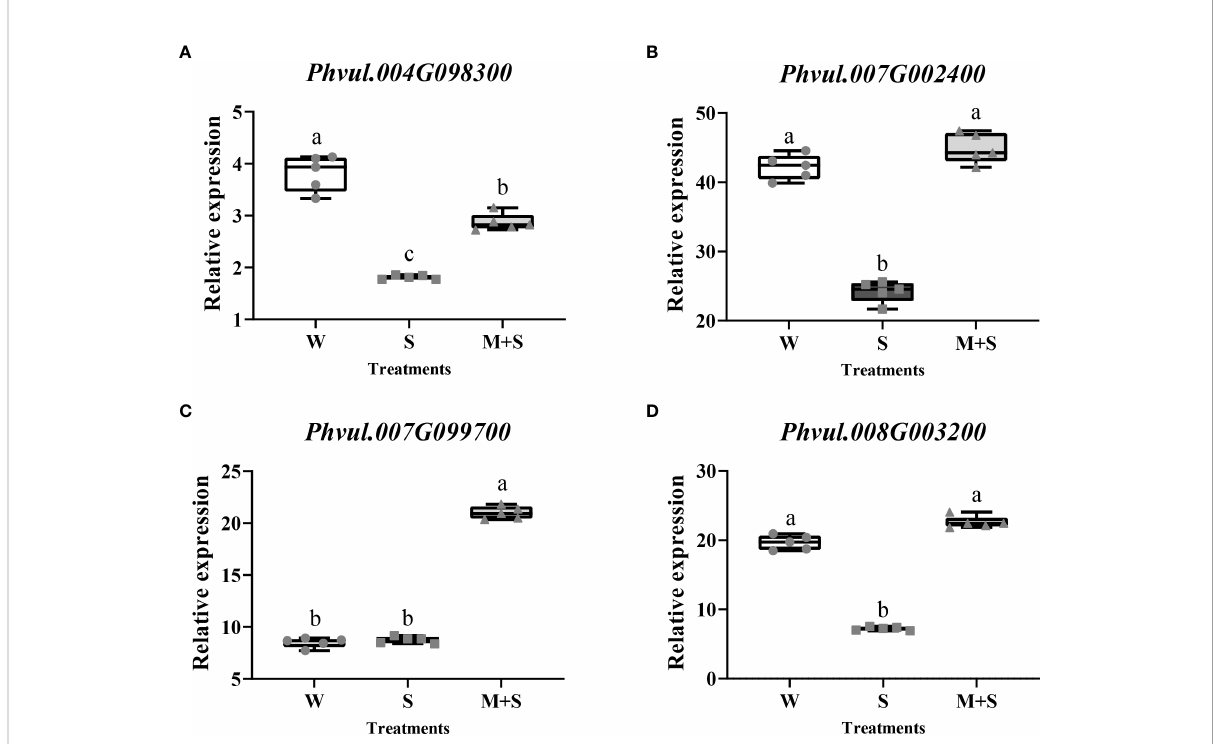
FIGURE 2 Gene expression analysis of the cell wall-related GO terms enriched in the common bean under W (water: CK), S (salt), and M+S (melatonin with salt) treatments at sprouting stage. Different lowercase letters in the same column indicate signi fi cant differences between the treatments (P<0.05). (A) Expression analysis of the Phvul.004G098300 . (B) Expression analysis of the Phvul.007G002400 . (C) Expression analysis of the Phvul.007G099700 . (D) Expression analysis of the Phvul.008G003200 .